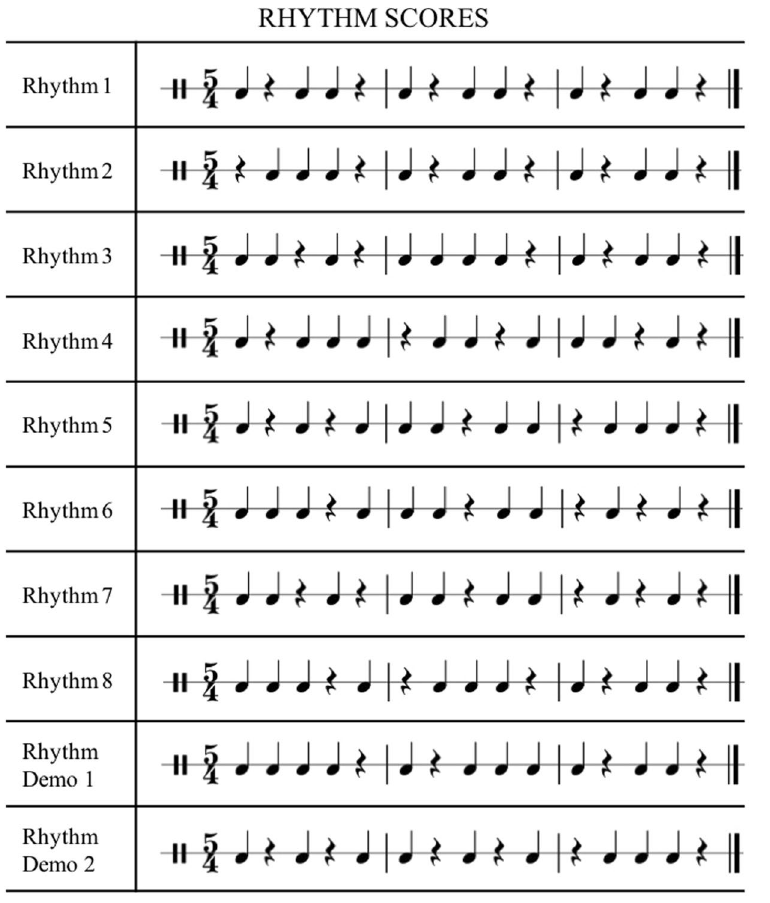
Figure 3. Scores of the rhythms used in the fMRI